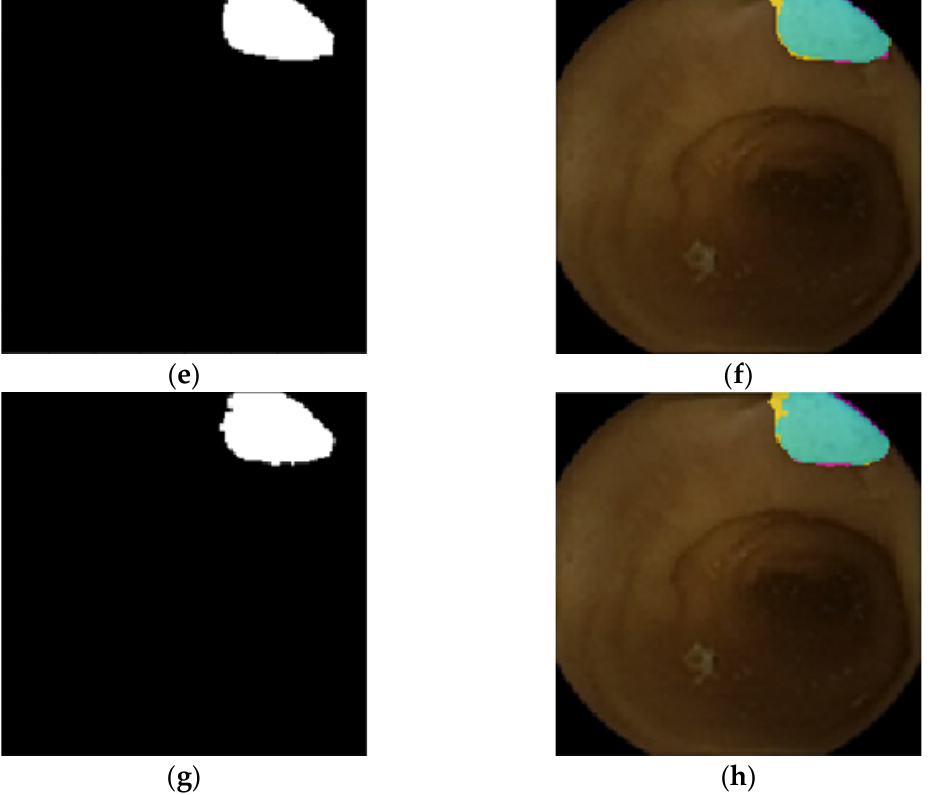
Figure 7. Sample confusion matrix visualization of sample CCE image: ( a ) Test polyp and ( b ) its related ground truth, ( c ) extracted polyp, ( d ) confusion matrix overlay mask extracted by U ‐ Net(4), ( e ) extracted polyp, ( f ) confusion matrix overlay mask extracted by AID ‐ U ‐ Net(3, 1), ( g ) extracted polyp, and ( h ) confusion matrix overlay mask extracted by AID ‐ U ‐ Net(2, 2) ( ■ (cyan): as TP pixels, ■ (magenta): as FP pixels, ■ (yellow): as FNs, and ■ (black) as TNs).